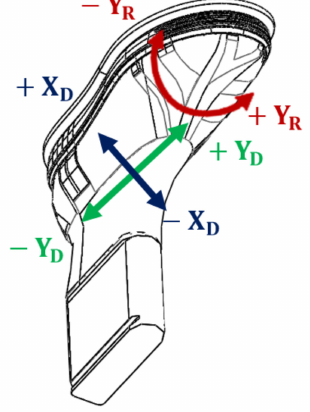
Figure 2. The possible wrong